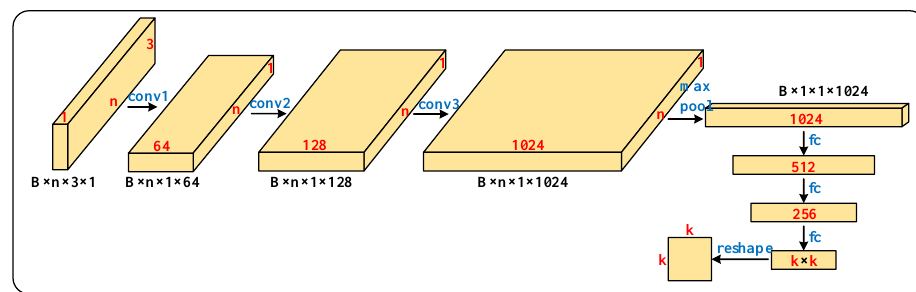
Figure 10. T-Net network structure.